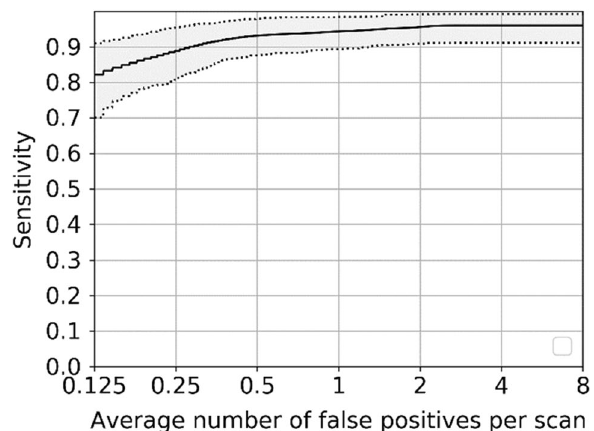
Figure 10. FROC curve of nodule detection system on LUNA16.